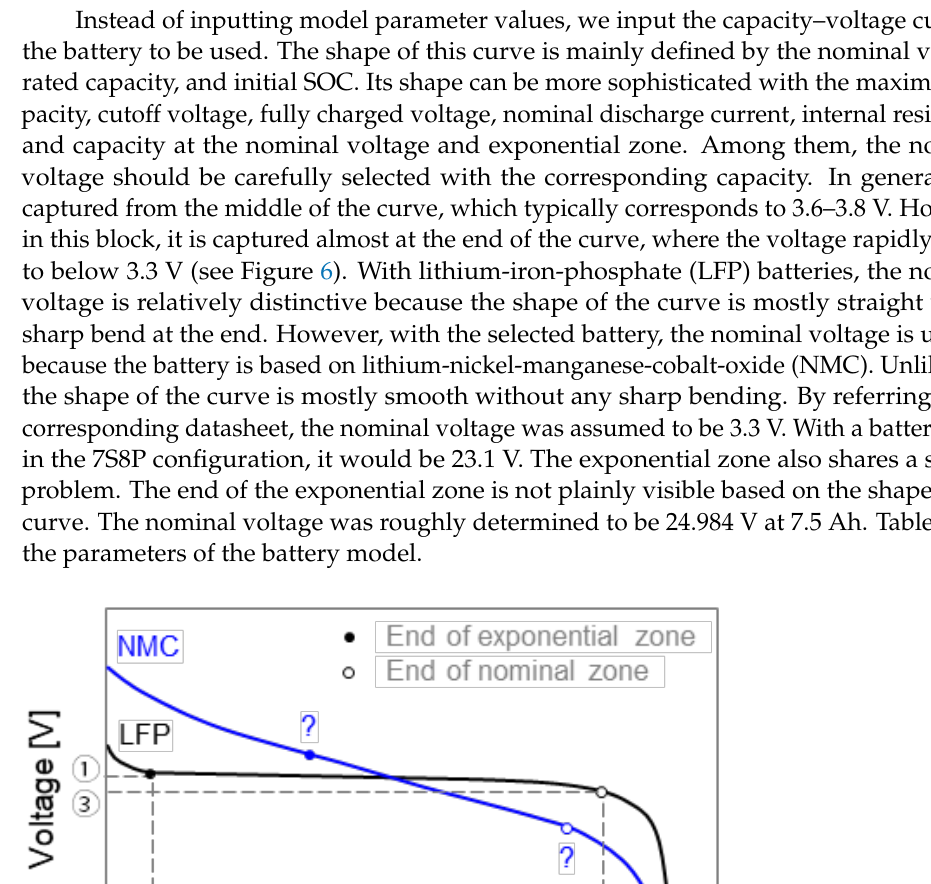
Figure 6. Comparison of NMC and LFP batteries in terms of extracting key parameters from the polarization curve. (1, 2) Exponential zone (V, Ah), (3) nominal voltage (V), and (4) capacity at nominal voltage (Ah).